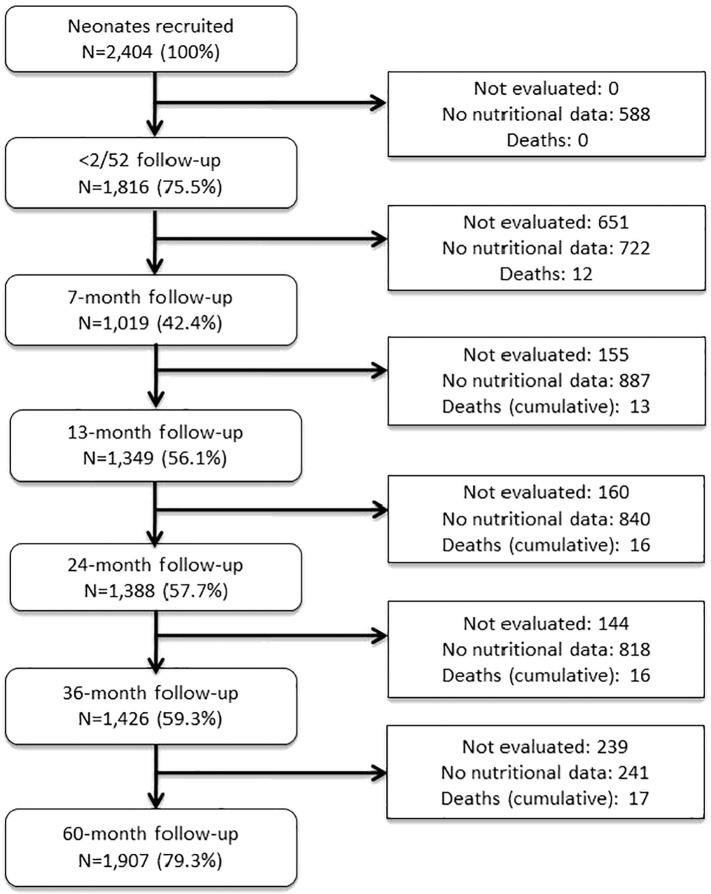
Illustration for the selection of the study population.